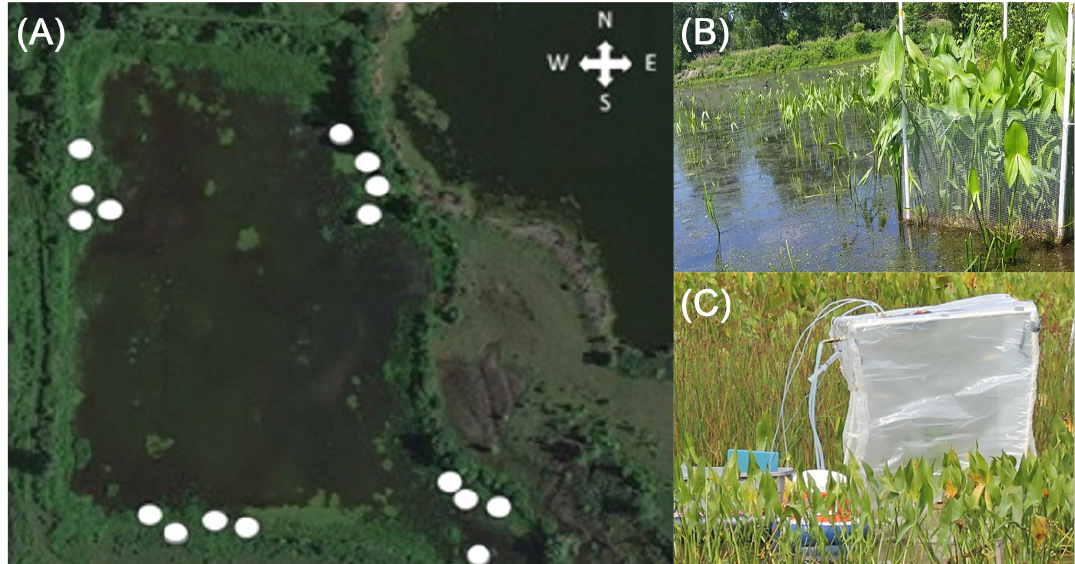
Figure 1. Experimental design at the North Pool of the Western Wetland complex at High Acres Nature Area in Western New York. ( A ) The site was divided into four blocks and the white markers indication locations of pairs of caged and uncaged plots, ( B ) cages were 1 m 2 and constructed of hardware cloth (photo credit: Kimberly Lodge), and ( C ) gas flux chambers were placed over the plots during measurements and were constructed from pvc pipe, clear polycarbonate sheeting and polyethylene greenhouse film that was rolled into the water and secured at the sediment surface (photo credit: Benjamin